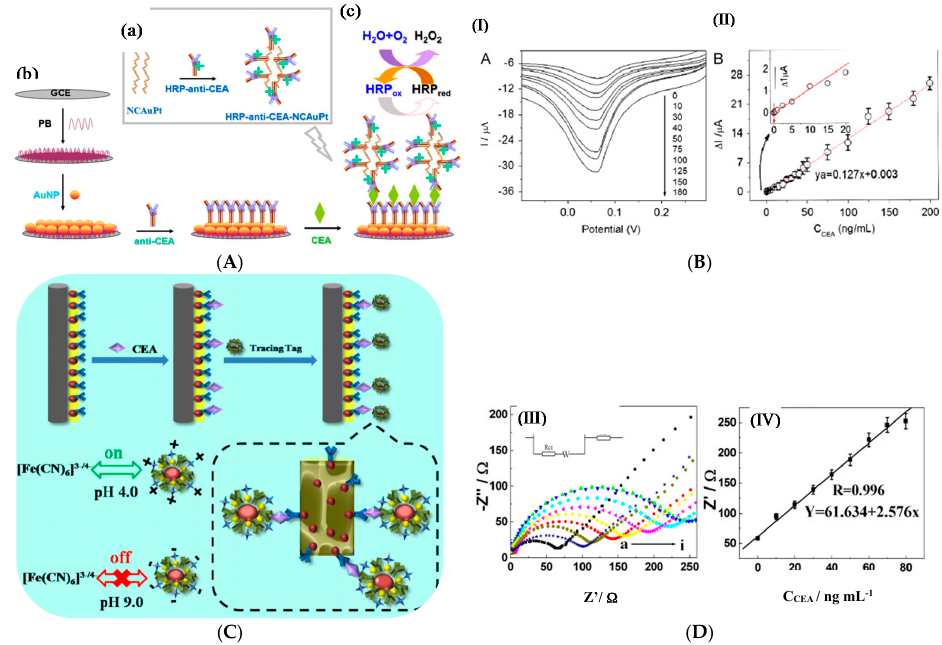
Figure 19. ( A ) ( a ) Preparation of the HRP-anti-CEA-AuPt nanochains as label; ( b ) sandwich-type recognition; ( c ) transduction. ( B ) Corresponding LSV (I) and calibration (II) curves for CEA at different concentrations in PBS + 0.8 mM H 2 O 2 . Reprinted from [105], Copyright 2013, with permission from Elsevier. ( C ) Detection of CEA with AuNPs-Ab 2 -GOx as label. ( D ) EIS (III) for CEA at different concentrations: (a) 5, (b) 10, (c) 20, (d) 30, (e) 40, (f) 50, (g) 60, (h) 70 and (i) 80 ng mL − 1 in 0.1 M KCl + 5.0 mM Fe(CN) 6 3 − /4 − ; (IV) corresponding calibration curve. Reprinted from [106], Copyright 2016, with permission from